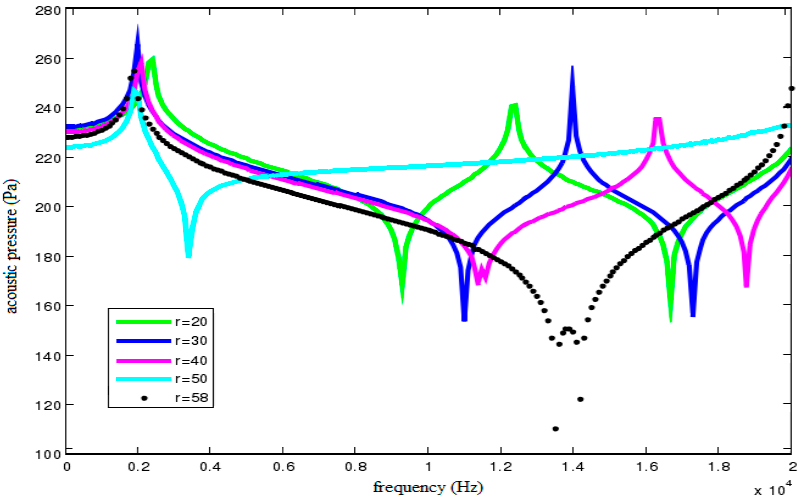
Figure 10. Acoustic pressure characteristic curves of field point A under different cavity radii.